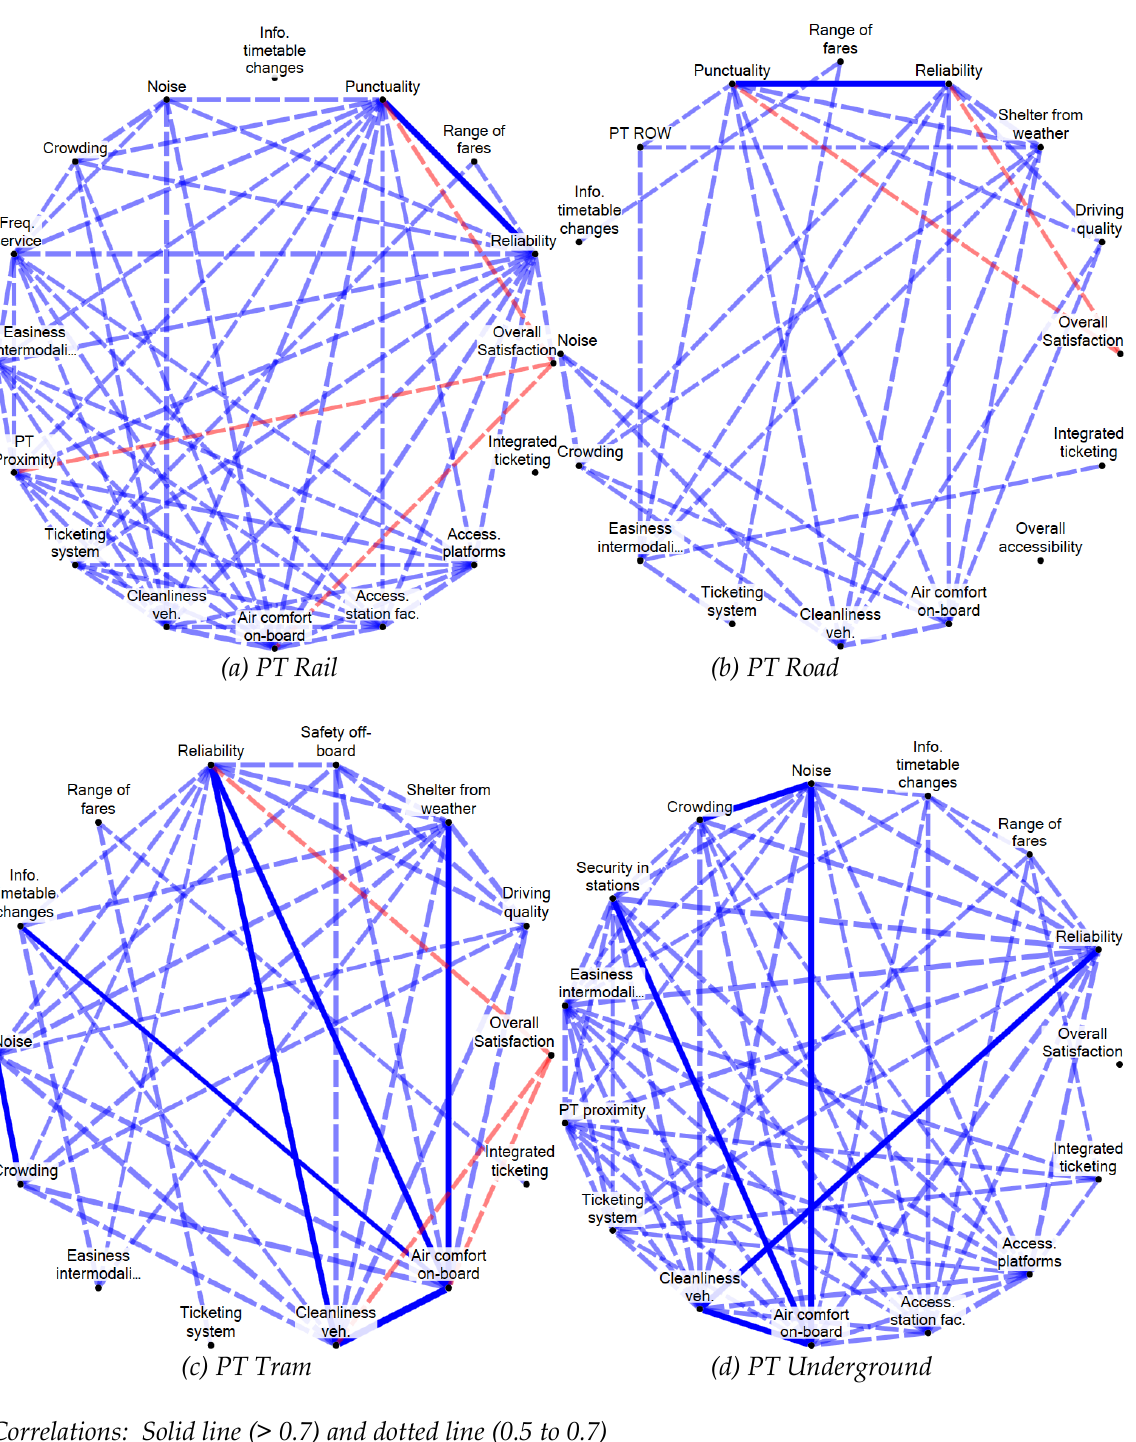
In red (with overall travel satisfaction) and in blue (between other variables) Figure 5. Cross-correlations among travel experience aspects and overall satisfaction on trip stages for different travel